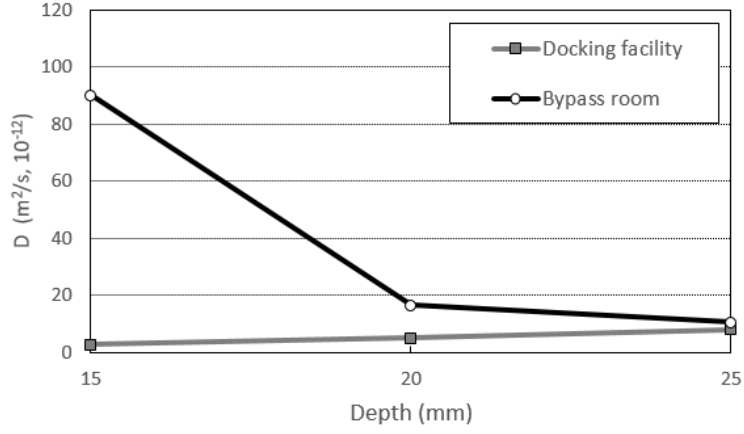
(4) where D RAP : diffusion coefficient at locations subjected to repetitive air pressure; D GAP : diffusion coefficient at a location subjected to general atmospheric pressure; x : depth. Table 7. Chloride concentration value and diffusion coefficient by location. Depth (mm)